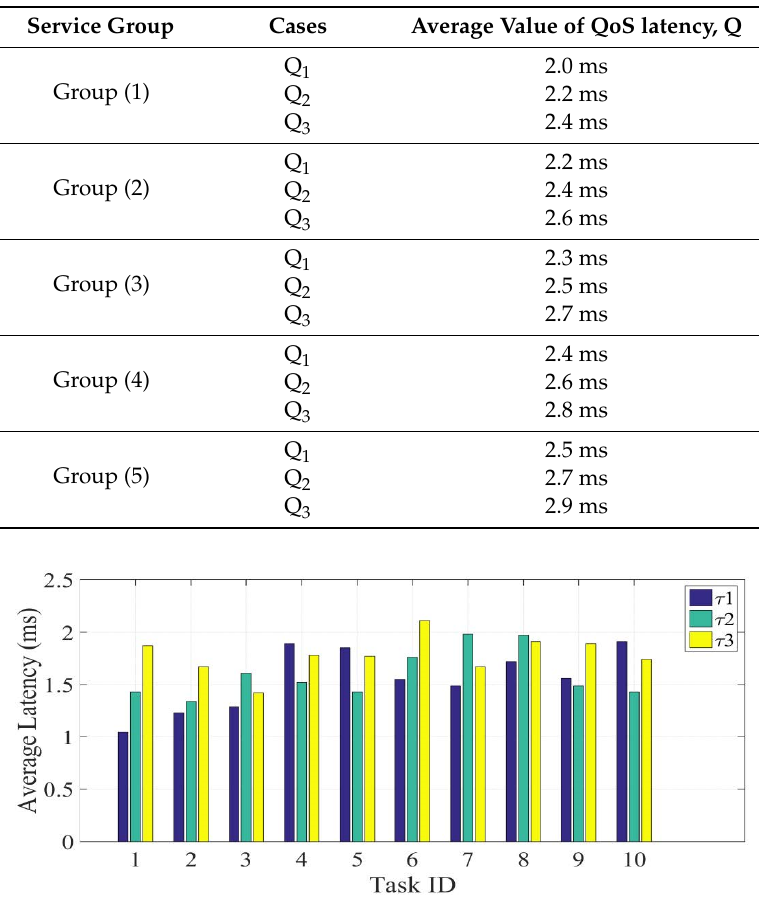
Table 7. Quality of service (QoS) latency of the considered tasks.